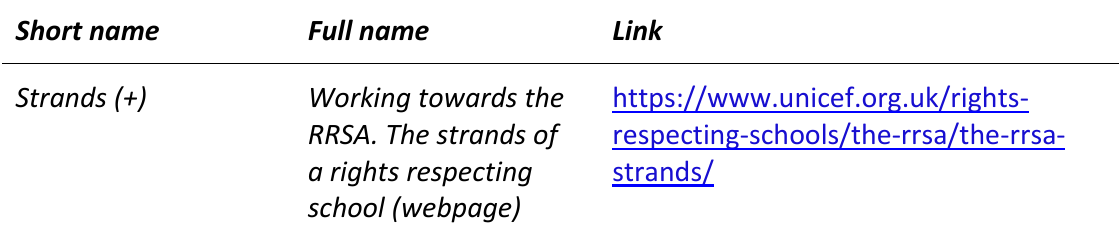
Legend and links to referenced UNICEF